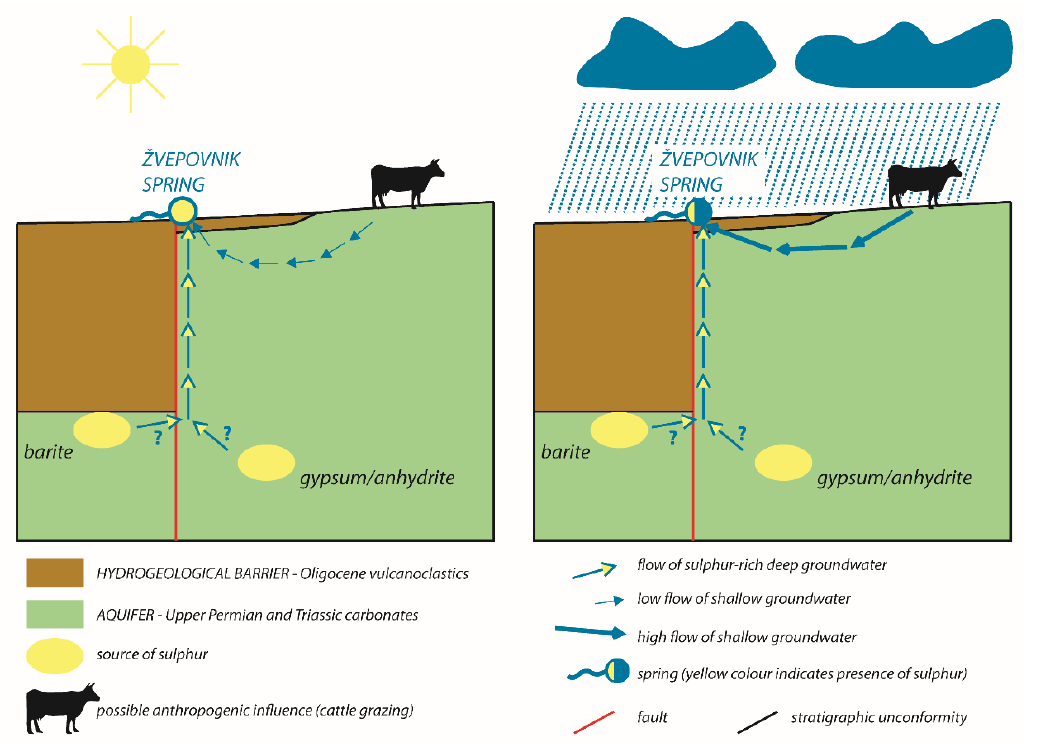
Figure 9. Schematic model of the Žvepovnik spring: sulphur-rich groundwater from the deep sulphidic or sulphatic (more probable) source is mixing with the shallow groundwaters.